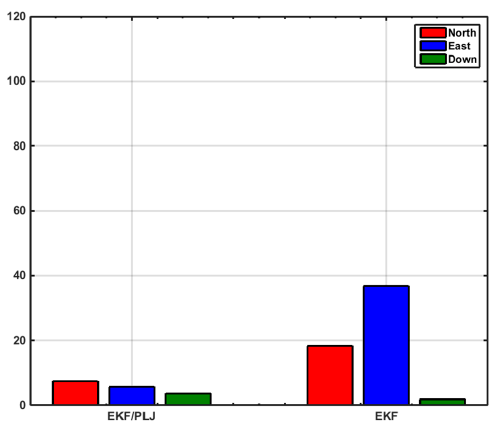
Figure 14. RMS Position Errors—Scenario #1.